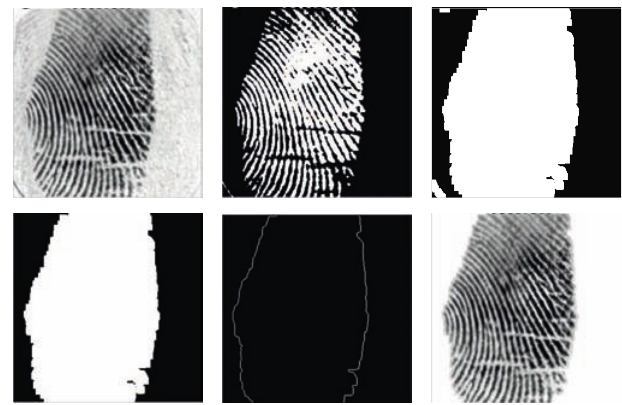
Figure 4. Coarse segmentation is employed to extract the foreground of the finger- print. Upper row: original image (left), binary image (middle), dilated image (right). Lower row: largest object (left), edge detection (middle), separating foreground im- age